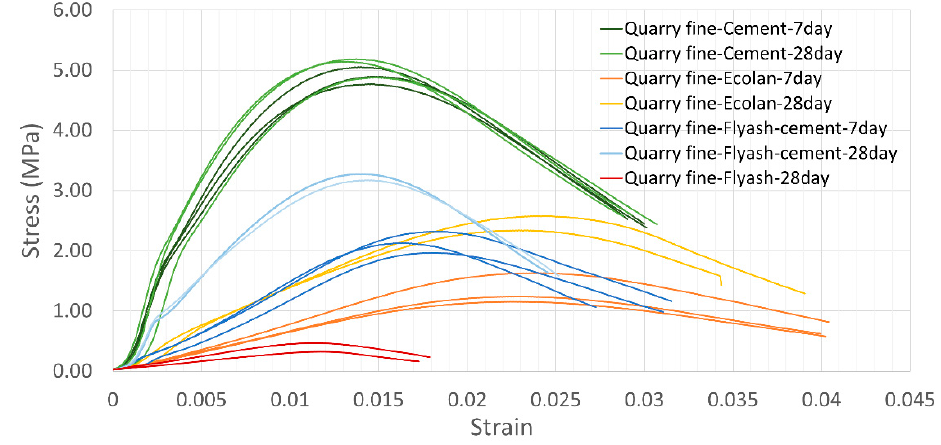
Figure 4. Effects of curing time on the unconfined compressive strength of stabilized quarry fines.